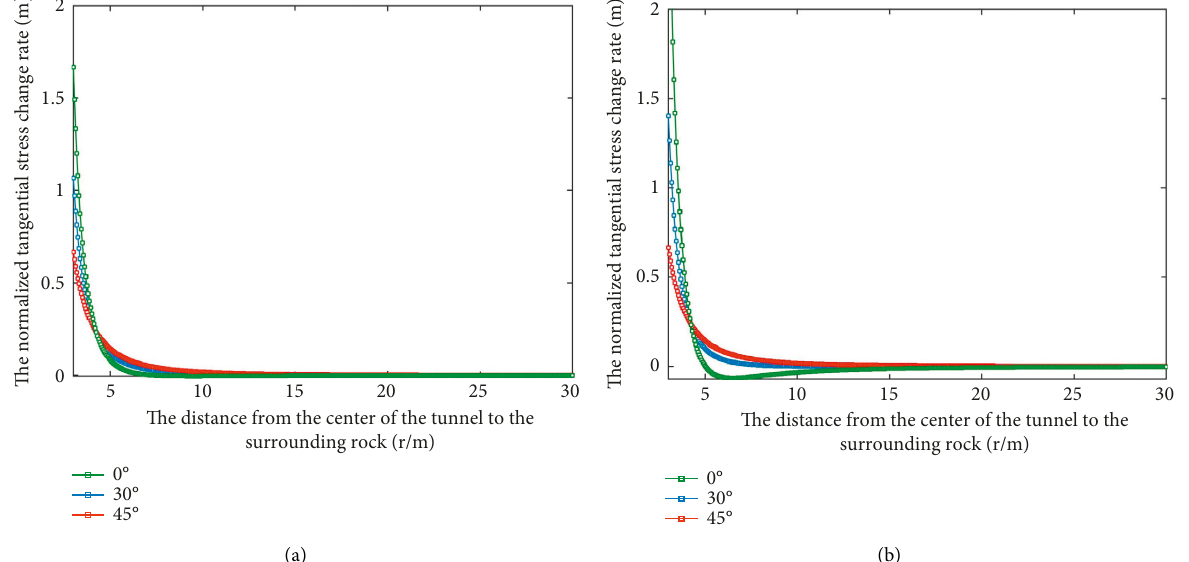
Figure 7: Radial stress change rates under different lateral pressure coefficients. (a) Lateral pressure coefficient λ � 0.3. (b) Lateral pressure coefficient λ �